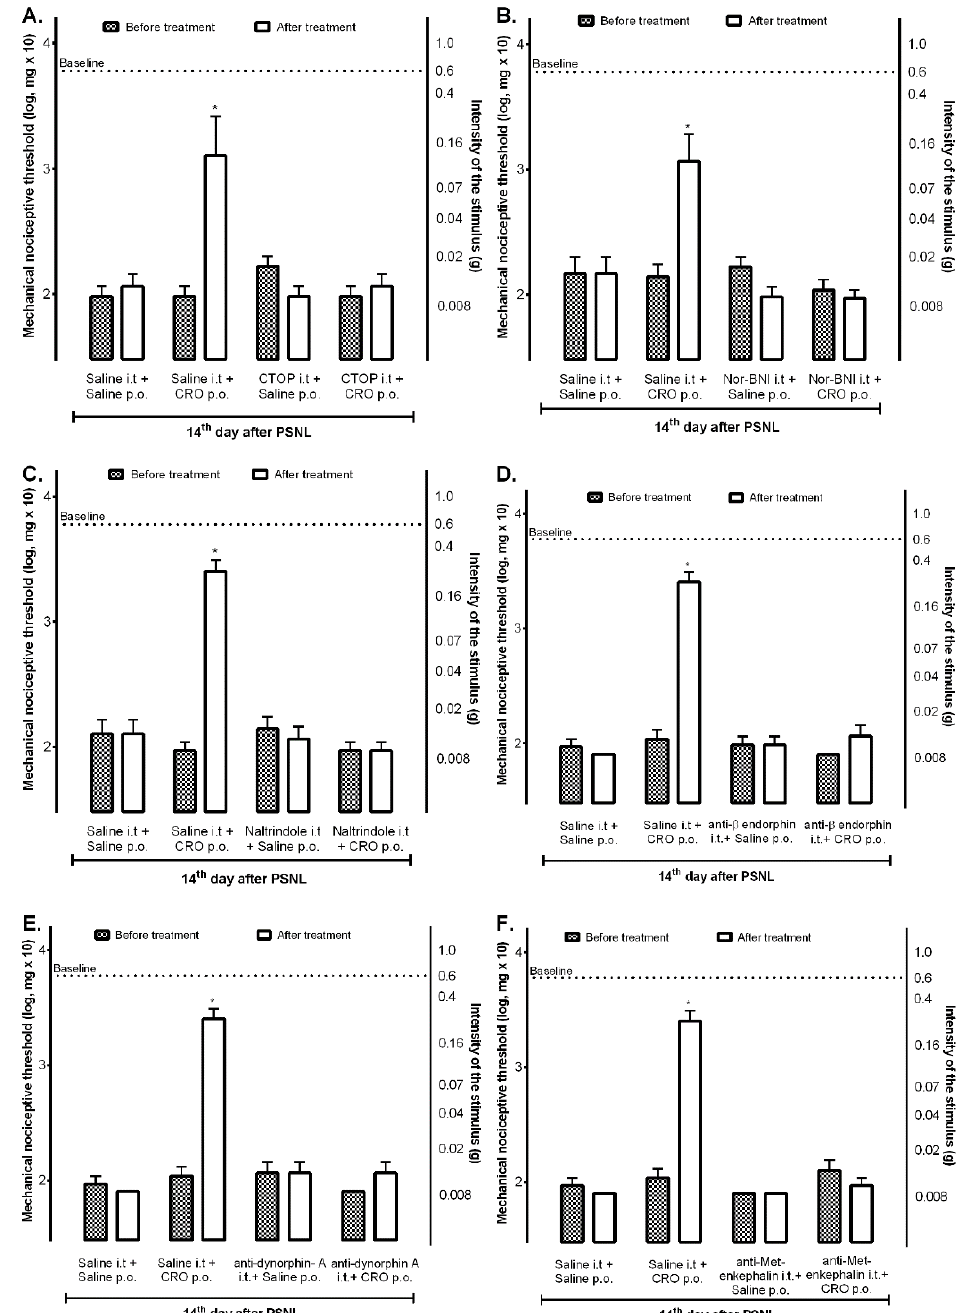
Figure 3. Involvement of the spinal opioid system in the crotalphine-induced analgesia. On the 14th day after the partial sciatic nerve injury (PSNL) surgery, the selective antagonists for mu ( A ), kappa ( B ), or delta ( C ) opioid receptors or specific antibodies for each endogenous opioid, anti- β -endorphin antibody ( D ), anti-dynorphin-A antibody ( E ) or anti-met-enkephalin antibody ( F ) were administered (i.t.). Crotalphine (CRO) (100 µ g/kg, p.o.) was administered 10 min after treatments. The nociceptive threshold was evaluated using von Frey filaments 1 h after treatment with CRO. The results are expressed by the mean of ± SEM. n = 6. * p < 0.05 statistically significant when compared with the PSNL + Saline i.t. + Saline p.o. before and after treatment. The two-way ANOVA test followed by the Sidak test was used.